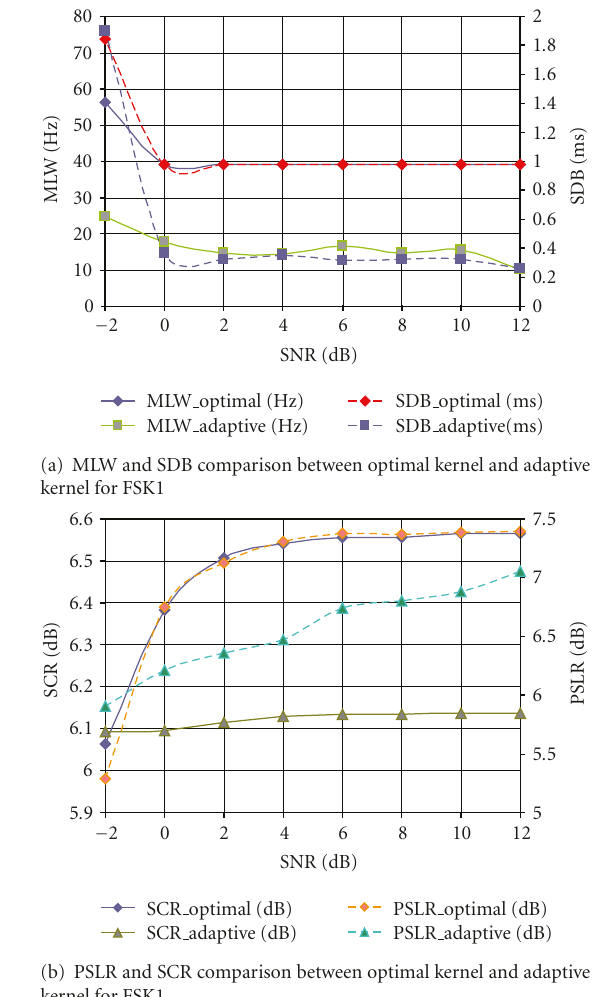
Figure 9: Performance comparison between optimal kernel and adaptive kernel for FSK1 in the presence of various SNR